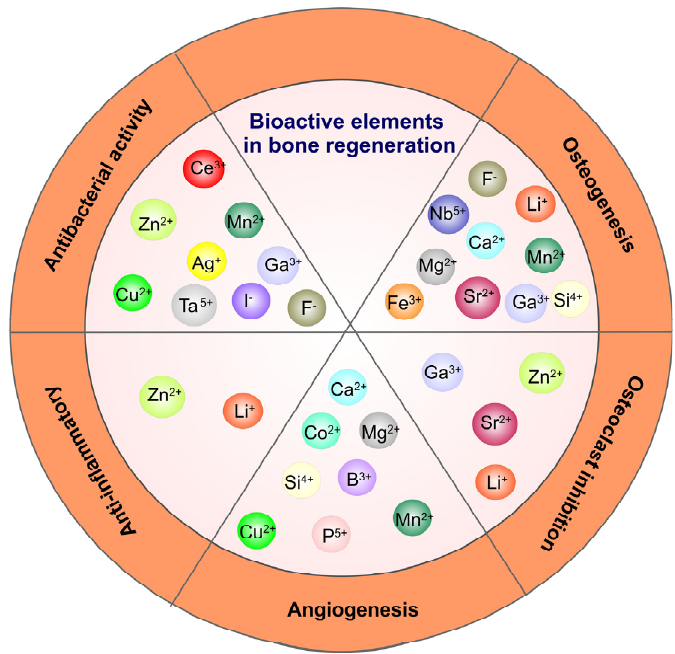
Figure 9. The therapeutic impact of some ions with angiogenic, osteogenic, anti-inflammatory and anti-bacterial